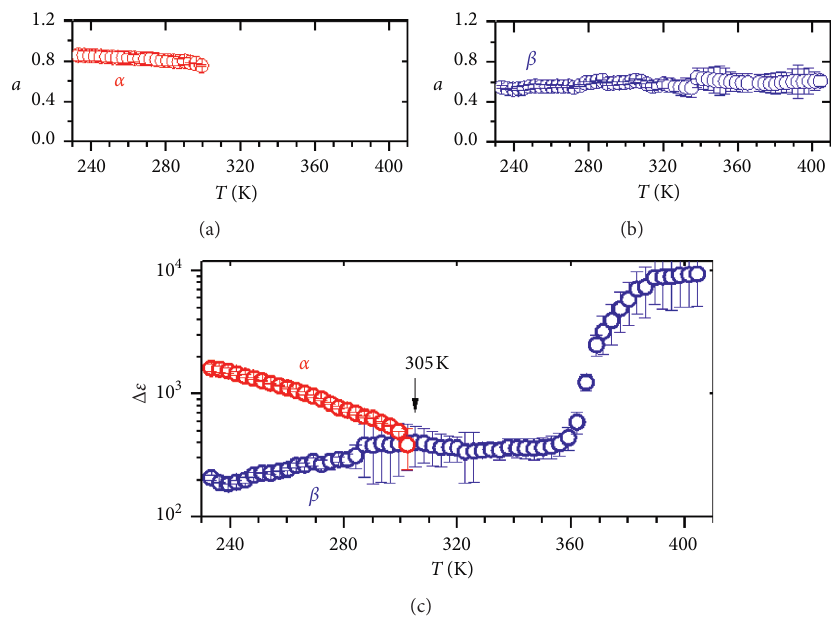
Figure 11: Temperature dependence of the (a), (b) shape parameter and (c) relaxation strength for the α and β